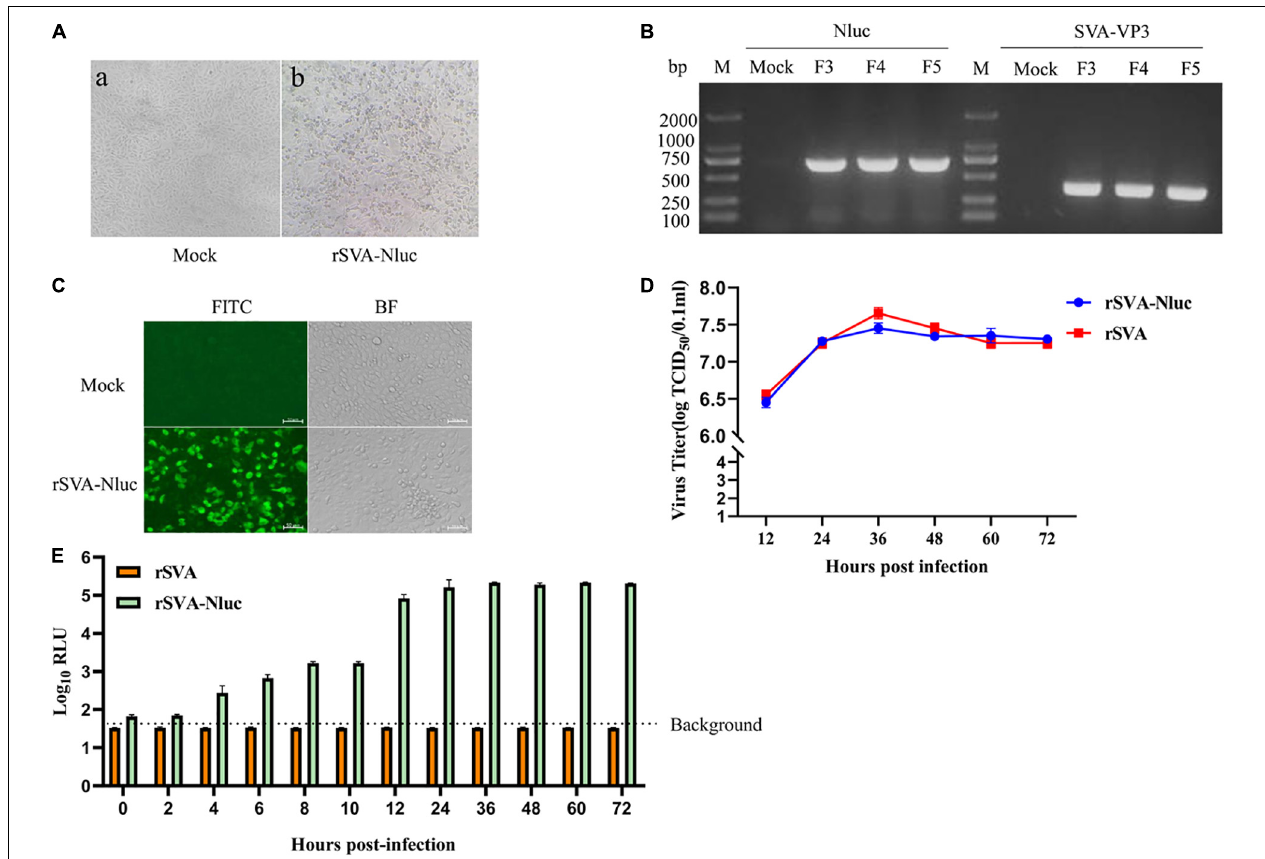
FIGURE 2 | Characterization of the SVA-Nluc. (A) Cytopathic effect (CPE) of the rSVA-Nluc cloned viruses in BHK-21 cells; Mock-infected cells were used as the negative control. (B) RT-PCR analysis of the Nluc gene and SVA VP3 gene at F3, F4, and F5 using Nluc-F/R and the VP3-F/R primer pairs. (C) Immunofluorescence assay (IFA) of the rSVA-Nluc in BHK-21 cells and mock control without virus infection. BHK-21 cells were infected with the rSVA-Nluc in 48-well plates at a multiplicity of infection (MOI) of 0.5 and analyzed using the indirect immunofluorescent assay at 24 h post-infection. (D) Multiple-step virus growth curve. BHK-21 were infected rSVA-HeB or rSVA-Nluc at an MOI of 0.5. Viral titers from culture supernatants at indicated time points were determined by the Reed–Muench method and expressed as 50% tissue culture infective doses (TCID 50 )/ml. Each data point shown represents the mean value from duplicates, and error bars show standard errors of the mean (SEM). (E) Time-course analysis of the nanoluciferase reporter gene expression. BHK-21 cells cultured in 24-well plates were infected with rSVA-HeB or rSVA-Nluc at an MOI of 0.5 and assayed for the Nluc activity in relative light units (RLU) at the indicated time points. Data represent mean values of three independent experiments with error bars representing the standard deviations of the